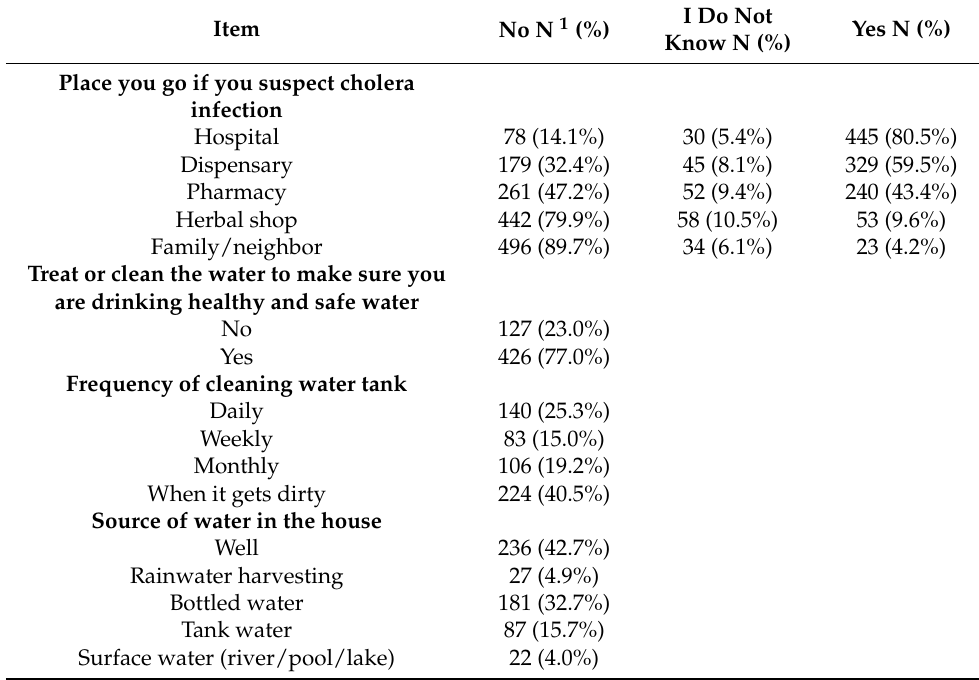
Table 4. Description of the cholera practice